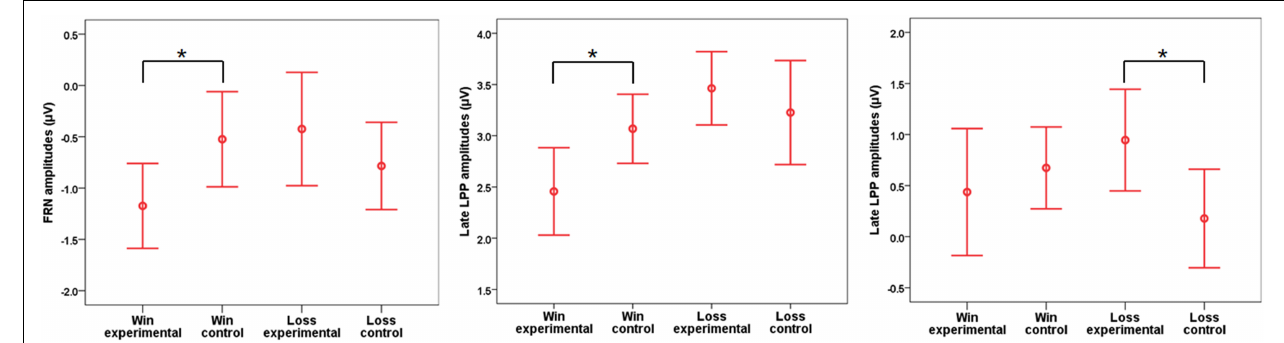
FIGURE 7 | Mean amplitudes of feedback-related negativity (FRN) (the left panel), early late positive potential (LPP) (the middle panel), and late LPP (the right panel) in each experimental condition. Error bars show 95% confidence intervals and are adjusted for within-subject designs. The symbol “*” indicates p < 0.05. Note that the significant values refer to the emotional effect in either the gain (FRN and early LPP) or loss (late LPP)